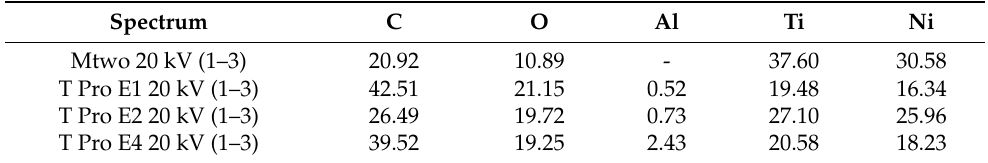
Table 1. Mean atomic weight percent (%) of Mtwo NiTi alloy endodontic rotary files, T Pro